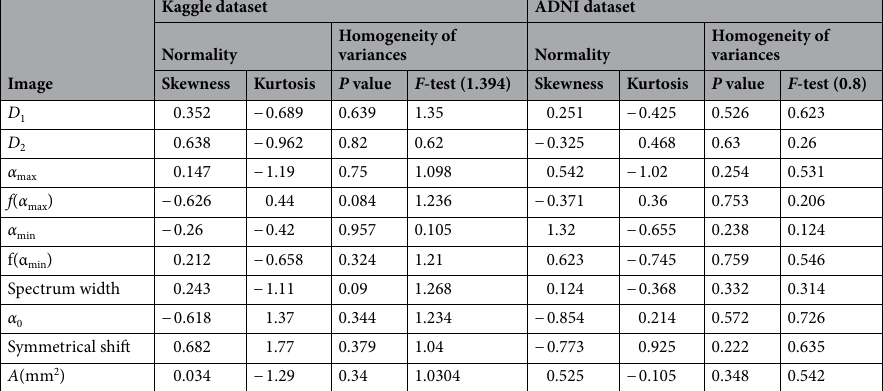
Table 3. ANOVA assumptions for the extracted features. where, F critical = 1.394 in case of Kaggle dataset and F critical = 0.8 in case of ADNI dataset according to F critical tables.